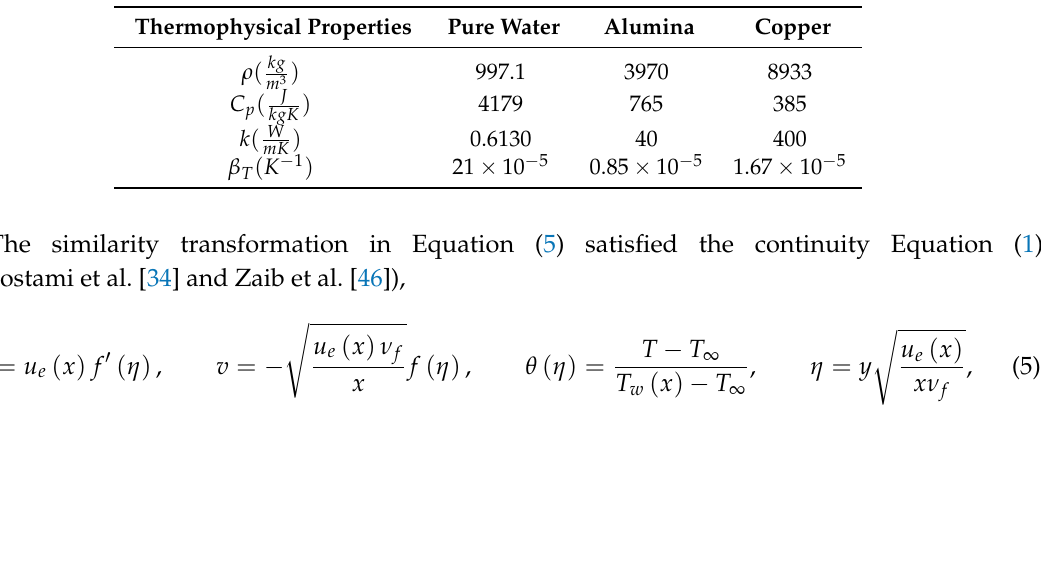
Table 3. Thermophysical properties for alumina, copper, and pure water (see Das et al. [61], Khanafer et al. [62] and Oztop and Abu-Nada [60], Cong et al. [25], and Ting et al.